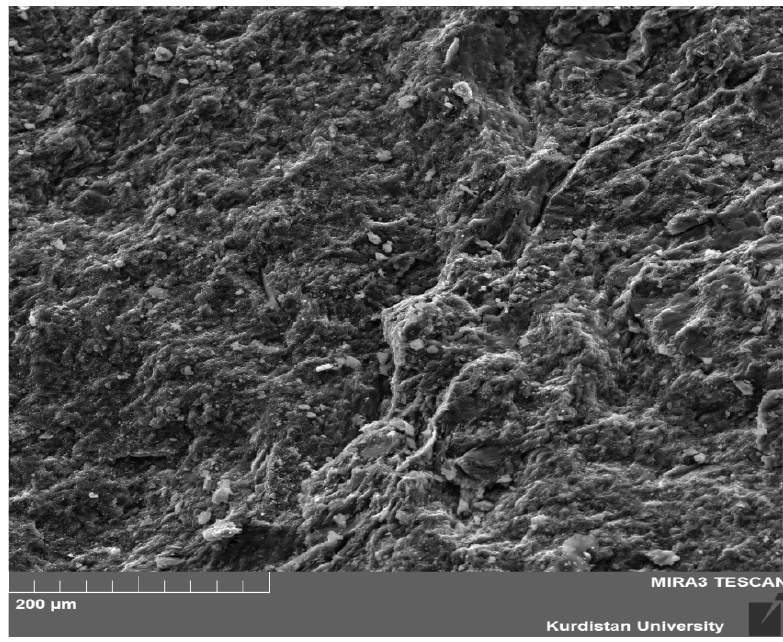
Figure 10. SEM of RCA-UNS 30% sample at 28